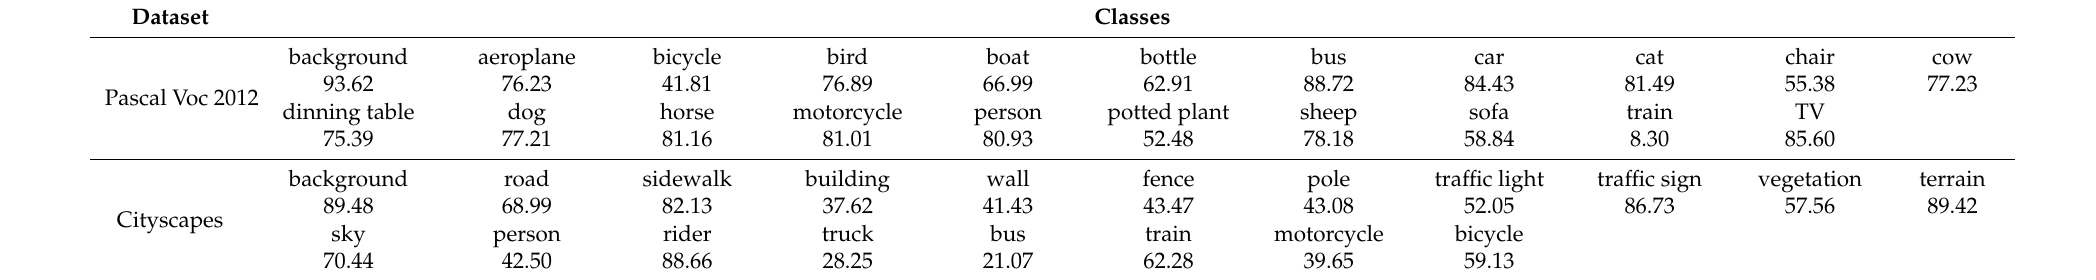
Table 17. IoU per class for Pascal VOC 2012 and Cityscapes